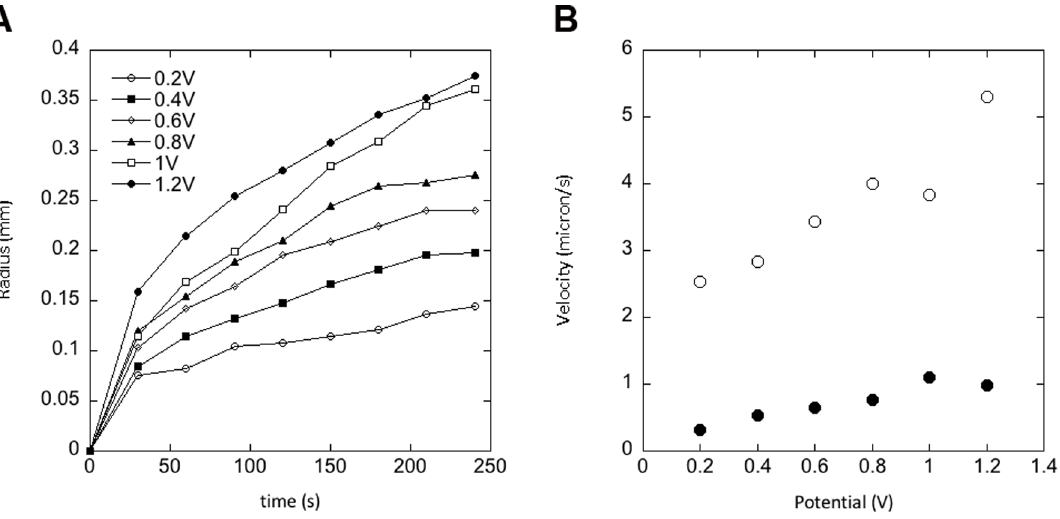
Figure 4. Growth of the gel phase around a bundle of silver plated copper wires immersed in a drop of 5.5wt% CNCs in water and held at different potentials from 0.2 to 1.2 V. A) radius of the gel phase as a function of time for each applied potential. B) Average growth velocity as a function of applied potential for the first 30 s (solid symbols) and after (open symbols).